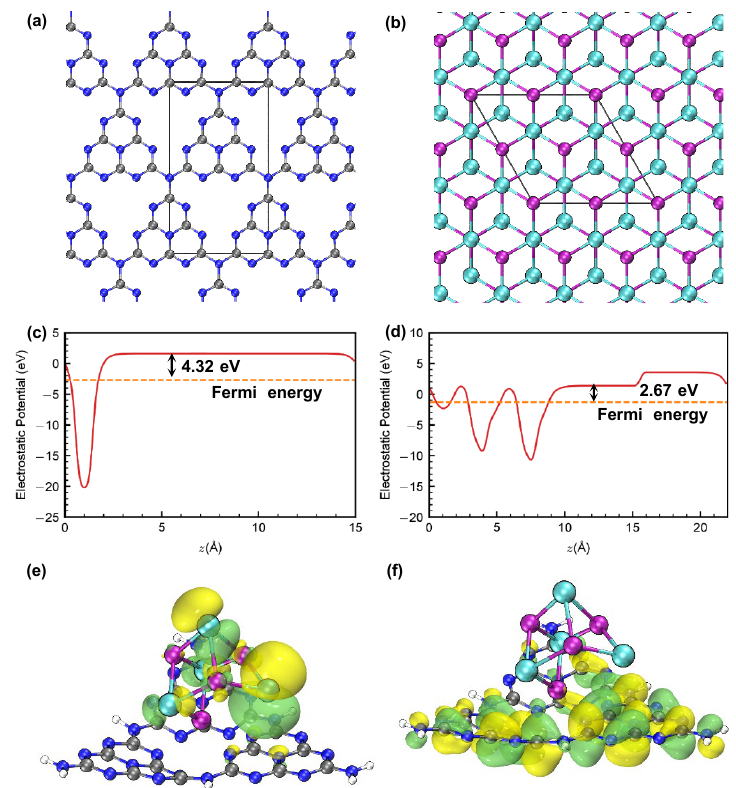
Figure 9. Structure of ( a ) CN and ( b ) CdSe. Electrostatic potential of ( c ) CN and ( d ) CdSe. ( e ) HOMO and ( f ) LUMO of CdSe/CN composites.